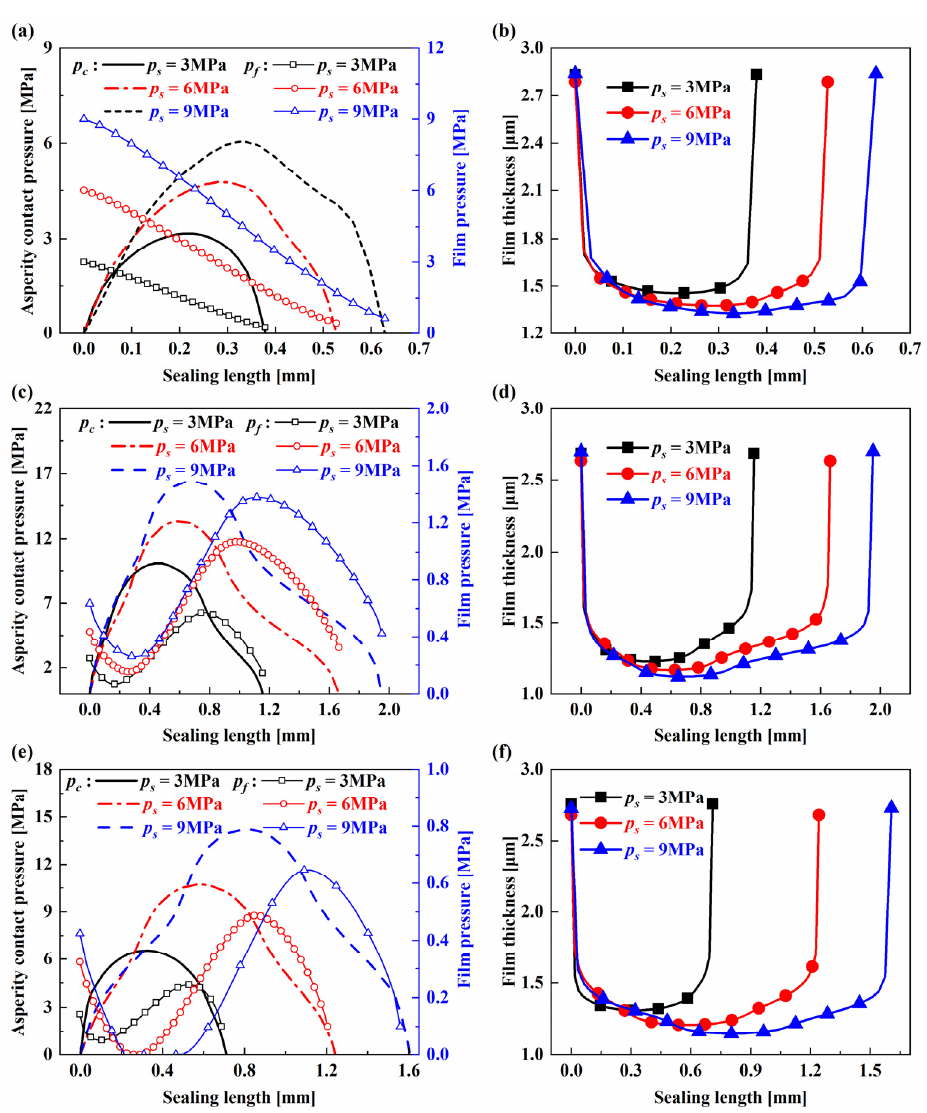
Figure 6. Pressure and film thickness distributions with different sealed pressure: ( a , c , e )pressure of the left lip, main lip, and right lip; ( b , d , f ) film thickness of the left lip, main lip, and right lip.